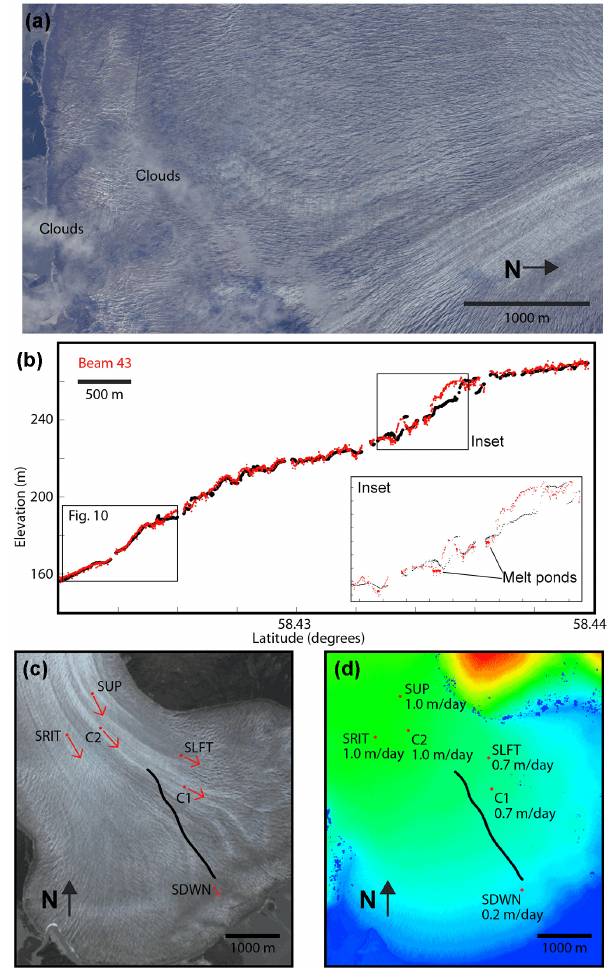
Figure 8. MABEL data over crevasse fields on the Lower Taku Glacier, from the 16 July 2014 flight. (a) Stitched MABEL cam- era images. (b) MABEL signal photons (red), migrated based on GPS data and corrected for an 8m range bias, and elevations ex- tracted from the WorldView-2 DEM (black). (c) WorldView-2 im- age (copyright DigitalGlobe, Inc.) with MABEL flight line and GPS sites (red). (d) WorldView-2 DEM (Moratto et al., 2010) with MA- BEL flight line and GPS sites (red).